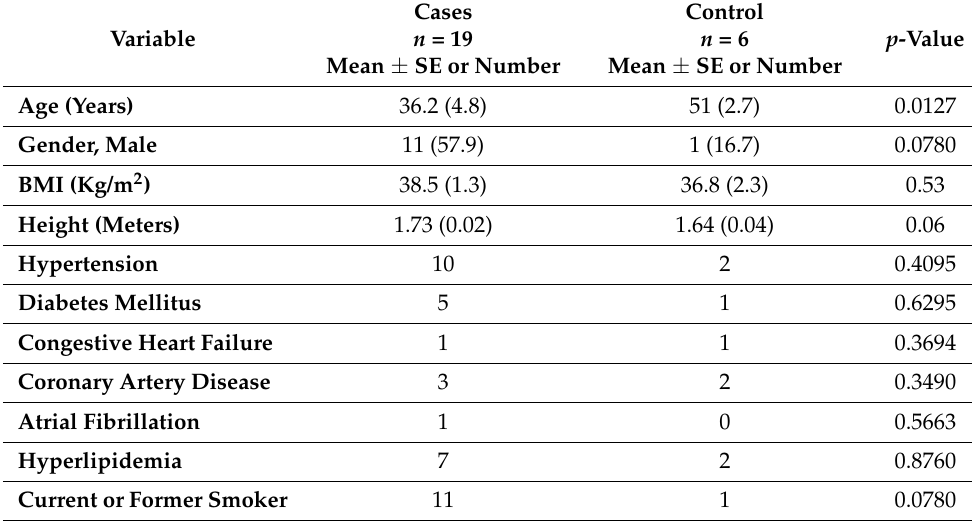
Table 1. Demographic and clinical characteristics of participants in this